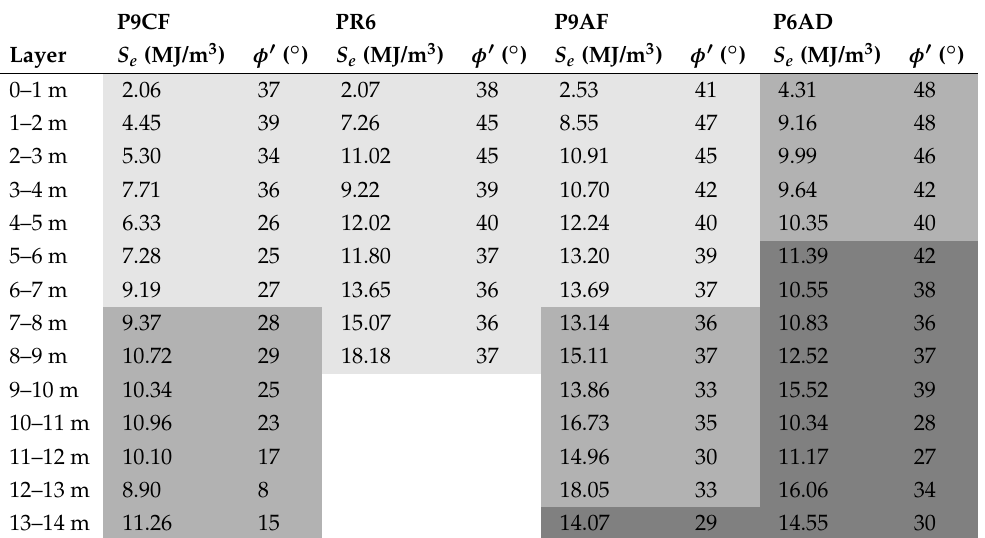
Table 1. Friction angle estimation. Color code: silty clay (light gray), clayey silt (medium gray), silt (dark gray).